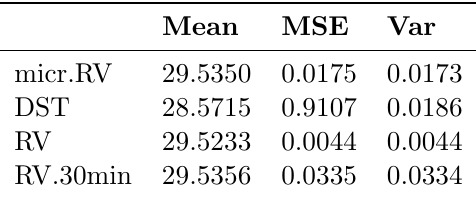
Simulation 1. Constant instantaneous volatility and no autocorrelation. Annualised volatility: